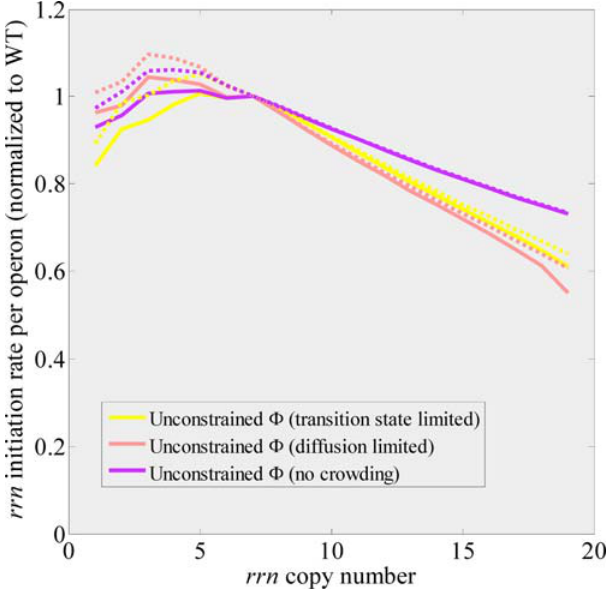
Figure 4. Initiation rate of a single rRNA operon ( V rrn ) for various crowding scenarios in the unconstrained CGGR model. Solid lines are predictions for the case where the rRNA chain elongation rate is assumed to be fixed at its WT value of 85 nuc/sec [17], while the dashed lines take into account the observed effect of rRNA operon copy number on rRNA elongation rates [54,65] (see text for further details). V rrn is given by Eq. 1. In each case considered, c ribo was obtained by fitting to the Squires